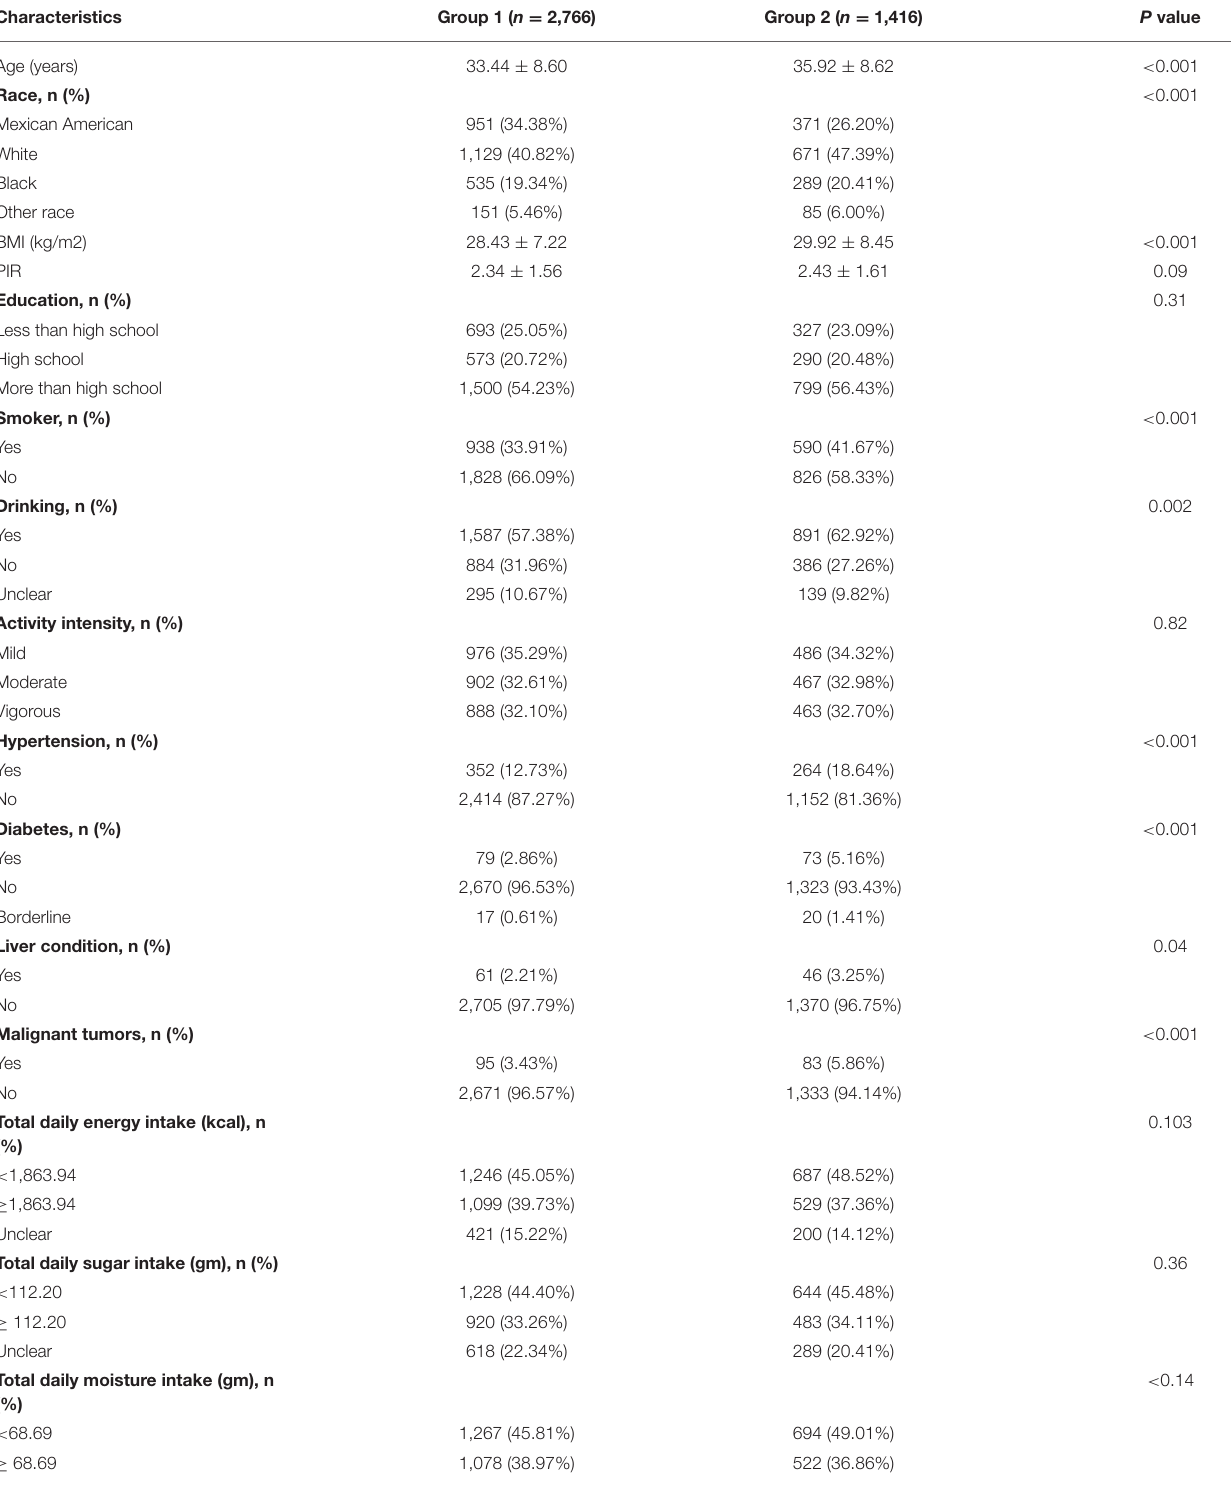
TABLE 1 | Characteristics of the